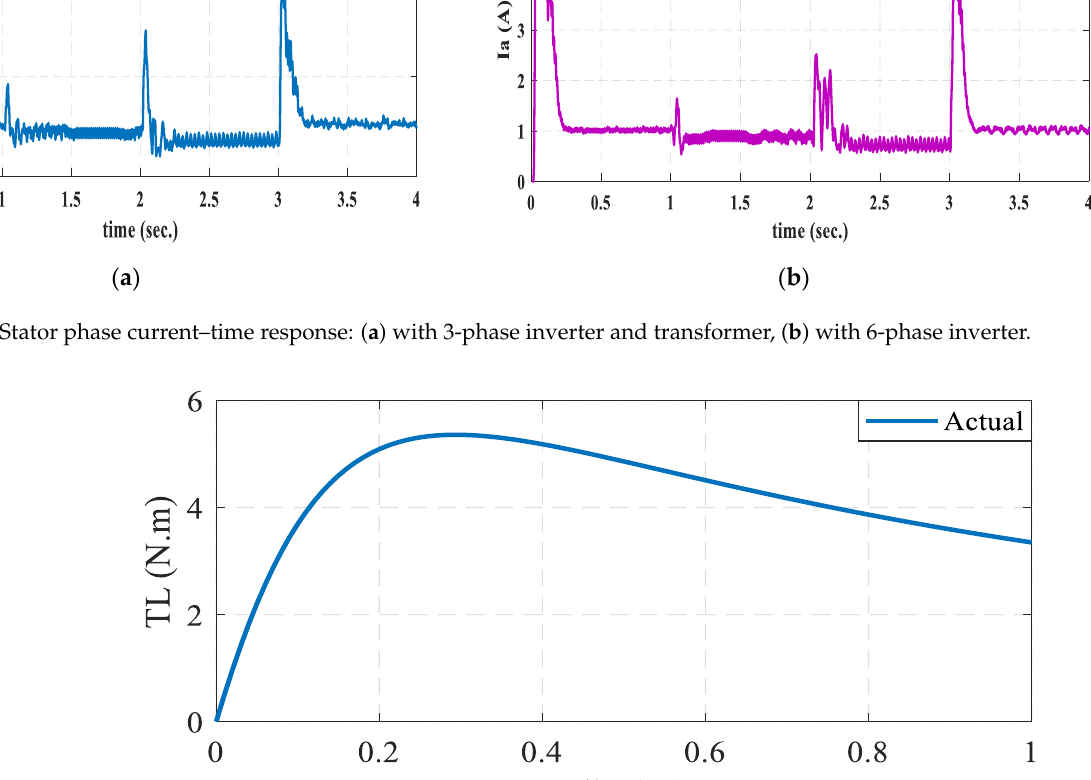
Figure 12. Torque–slip characteristics of the adapted six-phase induction motor.